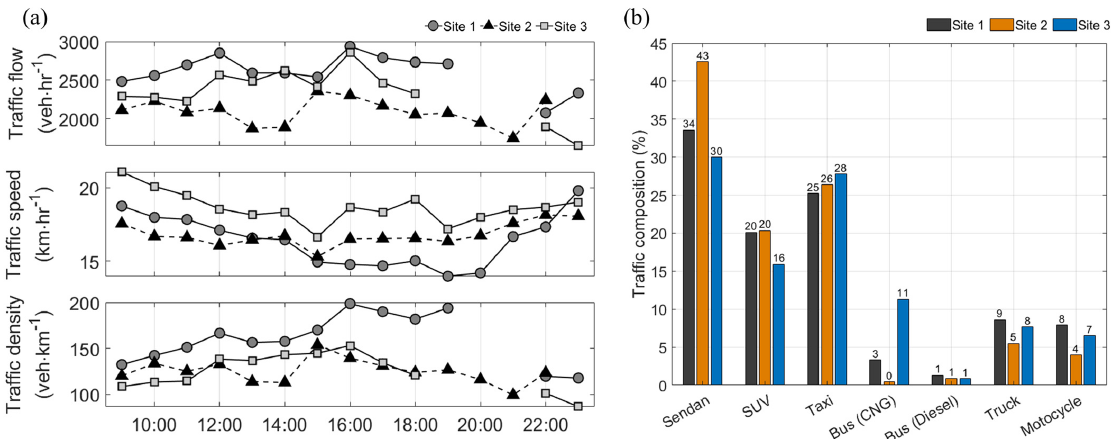
Figure 4. Weekday traffic characteristics at three sub-sites for the entire monitoring period. ( a ) Diurnal variations in the traffic flow rate (top), mean vehicle speed (middle), and traffic density (bottom; i.e., traffic flow rate divided by traffic speed). Dark gray circles represent Site-1, black triangles represent Site-2, and gray squares represent Site-3 (winter only). ( b ) Mean fleet composition (%) at each sub-site (traffic speed is provided by Transport Operation & Information Service managed by Seoul; https://topis.seoul.go.kr/refRoom/openRefRoom_1.do (accessed on 23 June